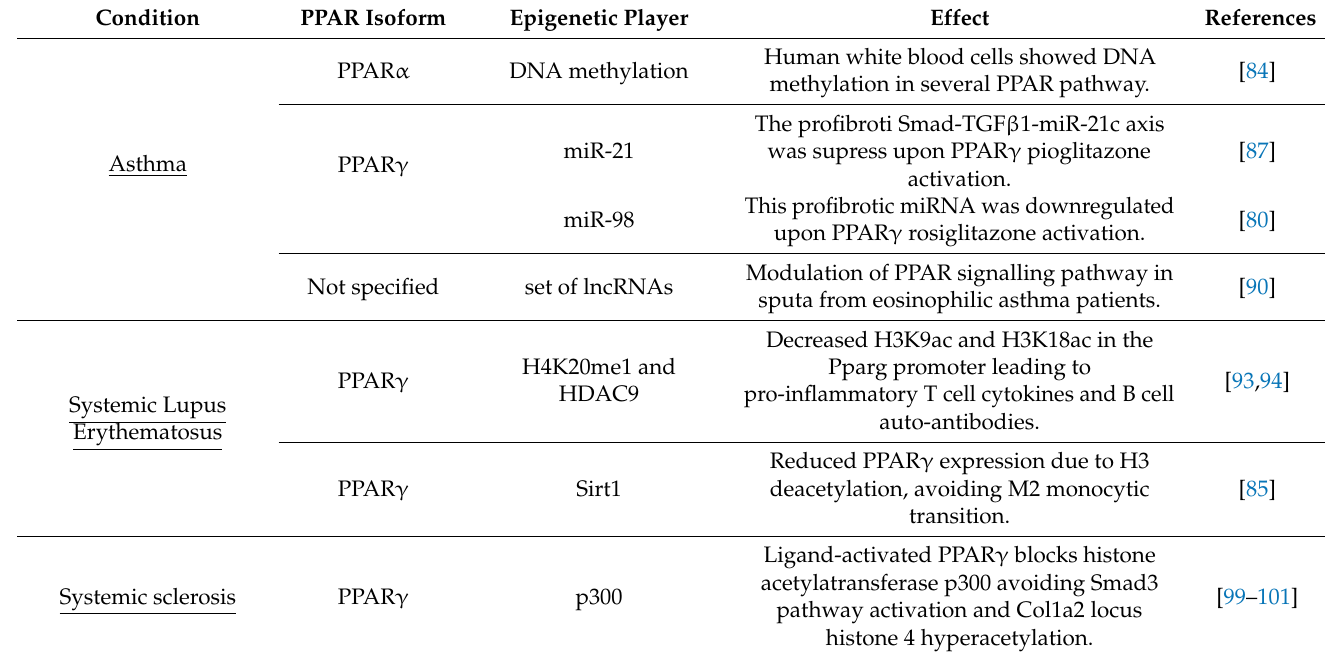
Table 2. PPAR epigenetics in autoimmune